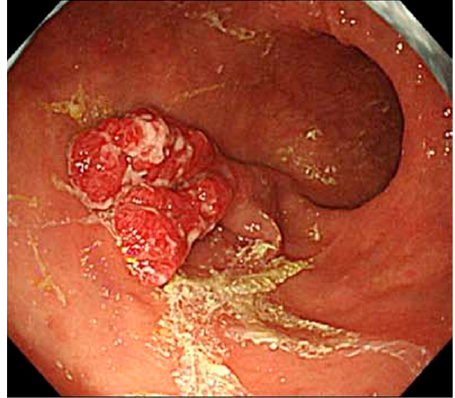
Figure 4. Image of hyperplastic polyp.